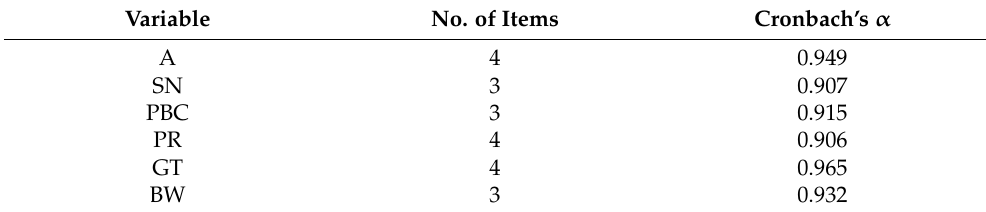
Table 5. Results of the reliability